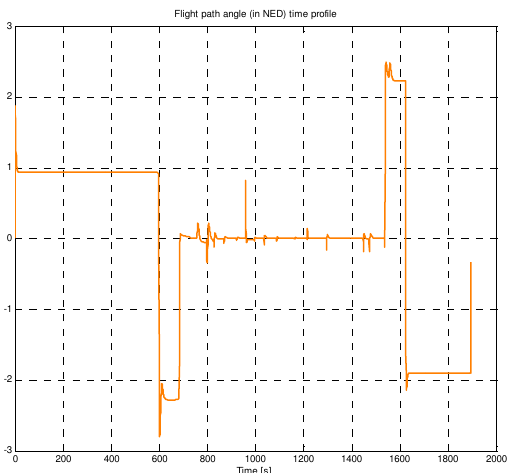
Fig 7. Flight path angle to satisfy altitude requirements specified by user